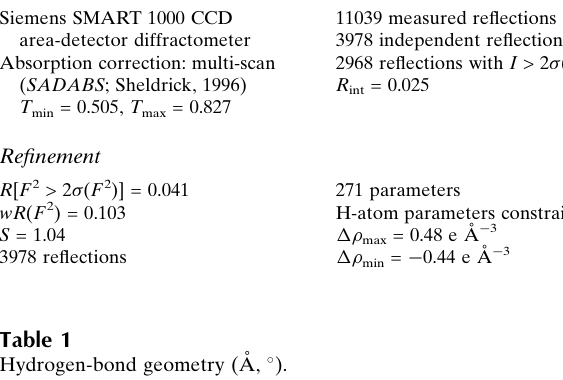
Hydrogen-bond geometry (A˚ , (cid:1)